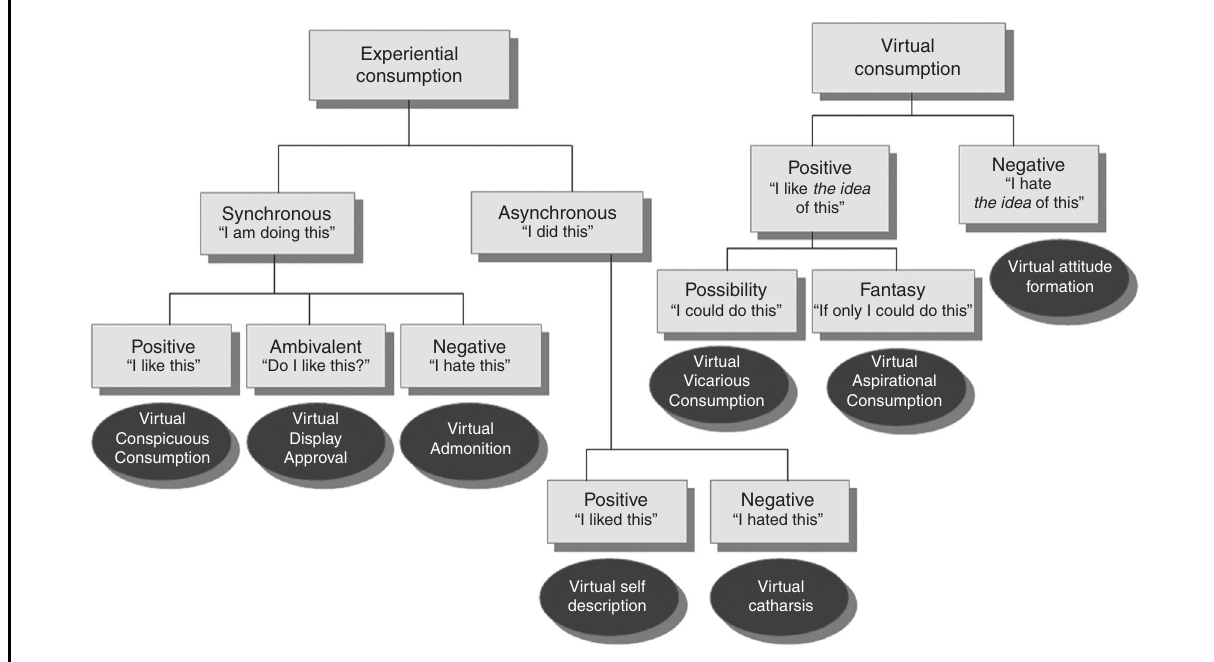
Figure 1 The virtual engagement